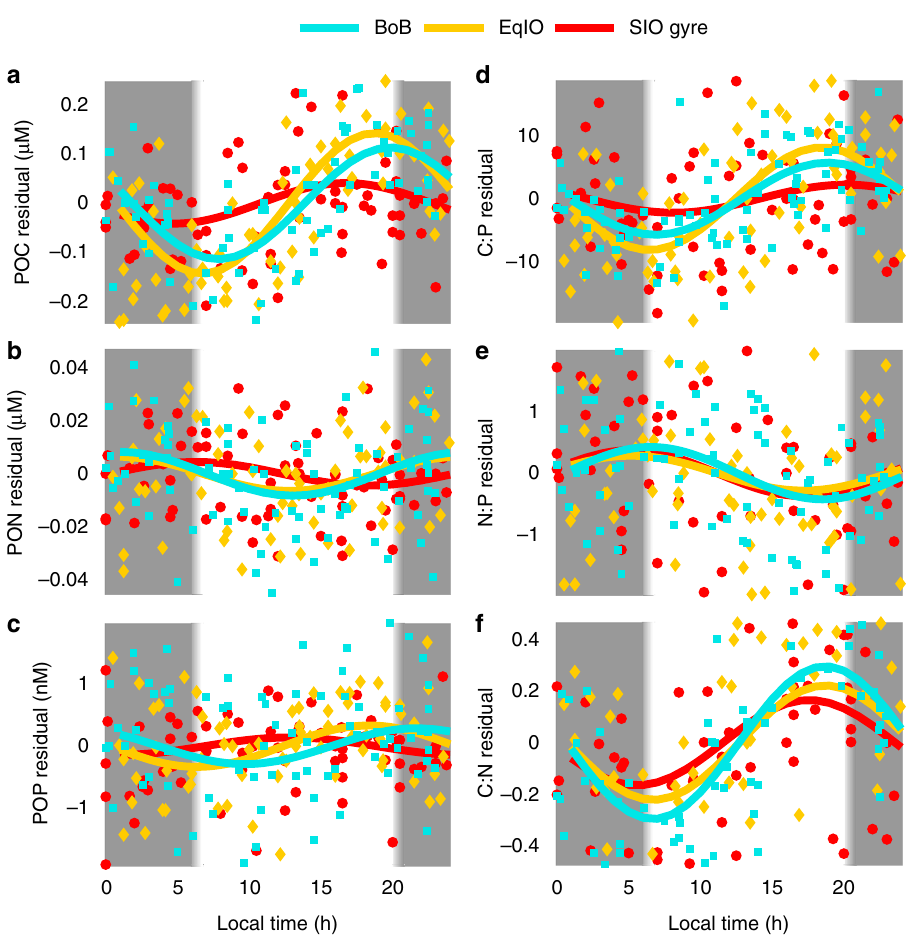
Fig. 3 Diel variation in POM concentrations and ratios. Residuals are calculated as follows: data points subtracted from the 8-point smoothed line for a particulate organic carbon (POC), b particulate organic nitrogen (PON), c particulate organic phosphorus (POP), d POC:POP (C:P), e PON:POP (N:P), and f POC:PON (C:N). Points were plotted and a sine curve was fi tted for each region. Bay of Bengal (BoB) is in cyan. Equatorial Upwelling (EqIO) is in gold. Southern Indian Ocean gyre (SIO gyre) is in red. The grey bar represents local nighttime and white bar represents